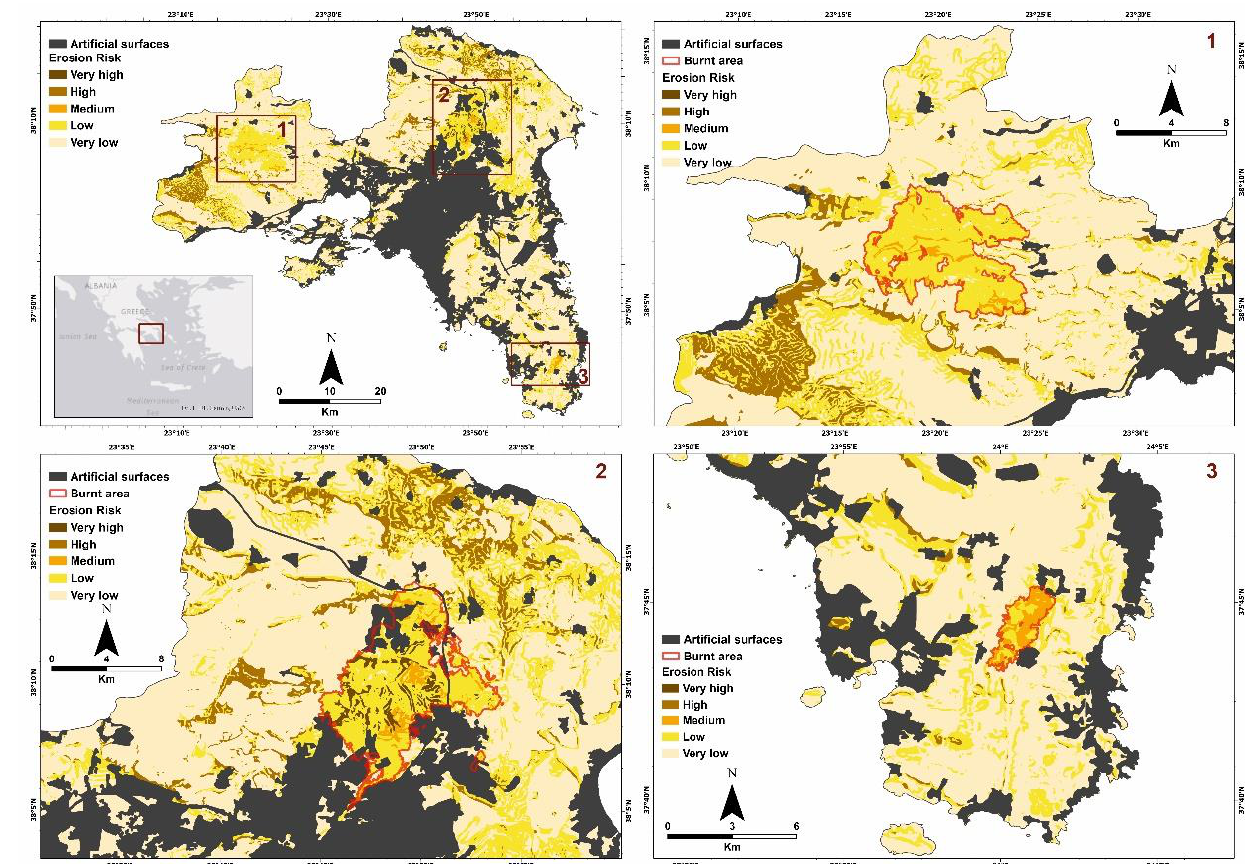
Figure 9. Results of erosion risk in the fire-affected area of Attica using a Boolean logic-based model. The map on the top right shows the erosion risk in the total investigated area, and the numbers correspond to the other three individual maps, where ( 1 ) is Attica, ( 2 ) is Villia and ( 3 ) is Lavrion.